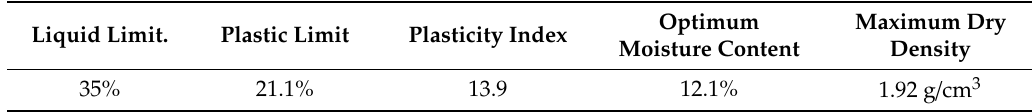
Table 5. Physical properties of silty clay.